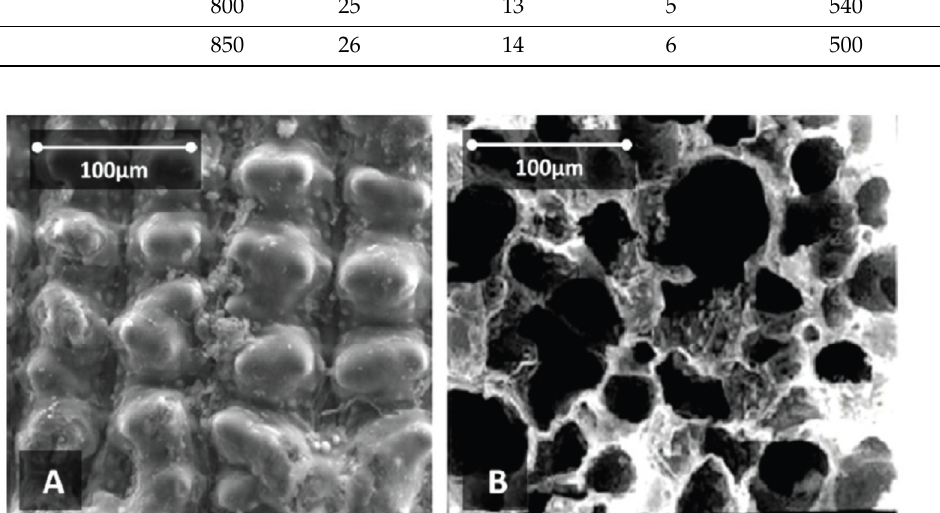
Figure 12. Electron microscopic images of rice shells in native state ( A ) and after carbonization at 650 °C ( B ). Reprinted with permission from Ref. [50]. Copyright 2020, Jenny Stanford Publishing Pte. Ltd.